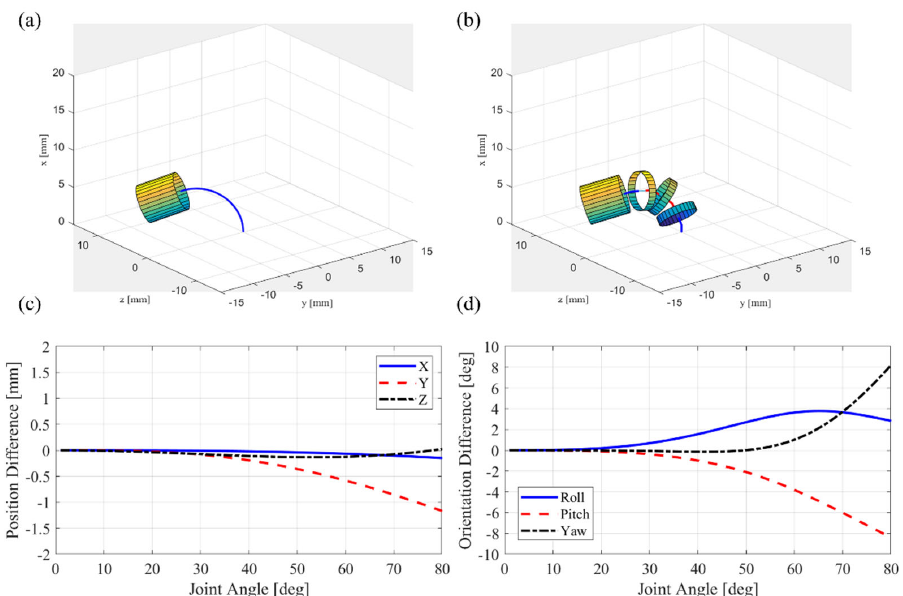
Figure 6. Comparison of forward kinematics between curvature model and joint model: ( a ) curvature model; ( b ) joint model; ( c ) position difference; ( d ) orientation difference.